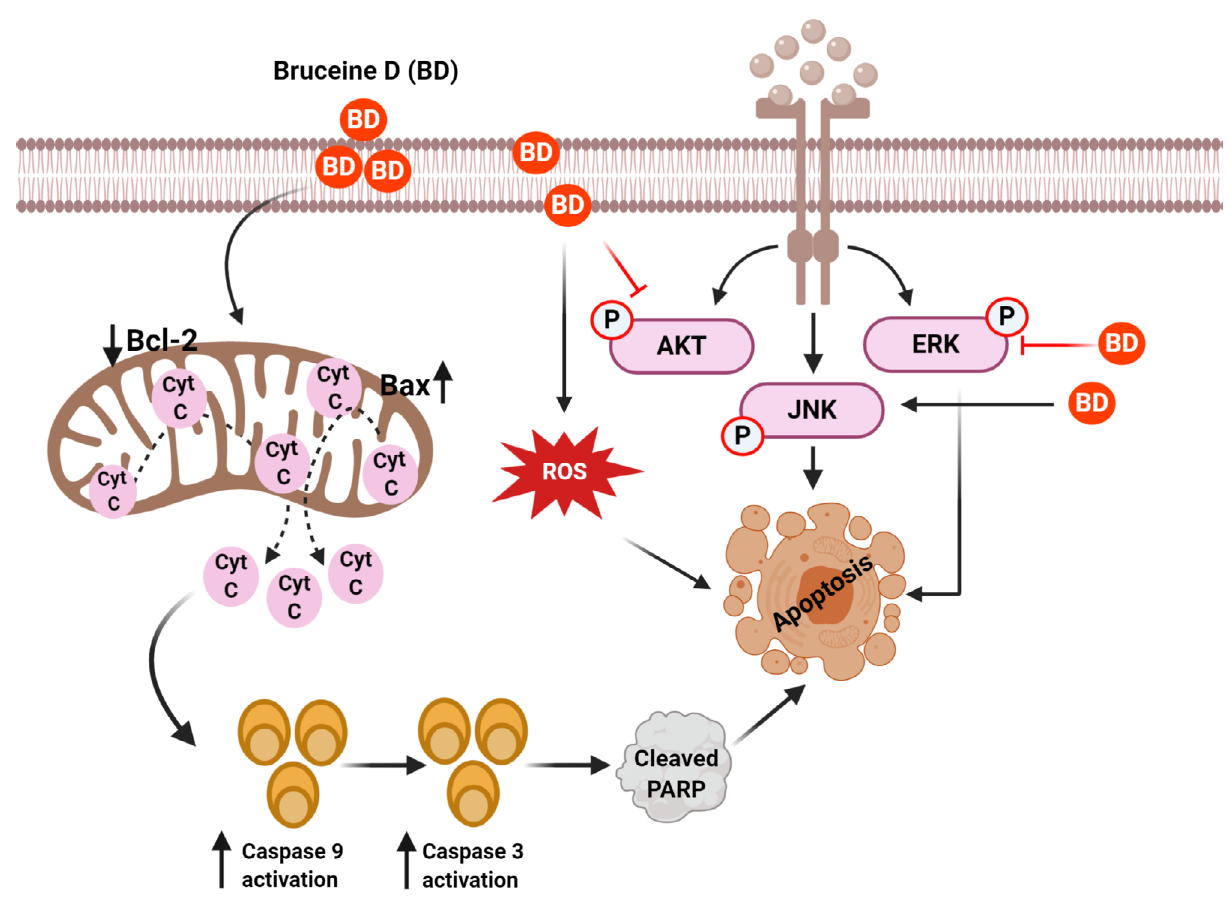
Figure 1 . Mechanisms of BD for its anticancer effect in human cancers. BD treatment suppressed the AKT/ERK and activate the JNK signaling cascades to induce apoptosis of cancer cells. BD caused apoptosis of cancer cells by regulating ROS and mitochondrial